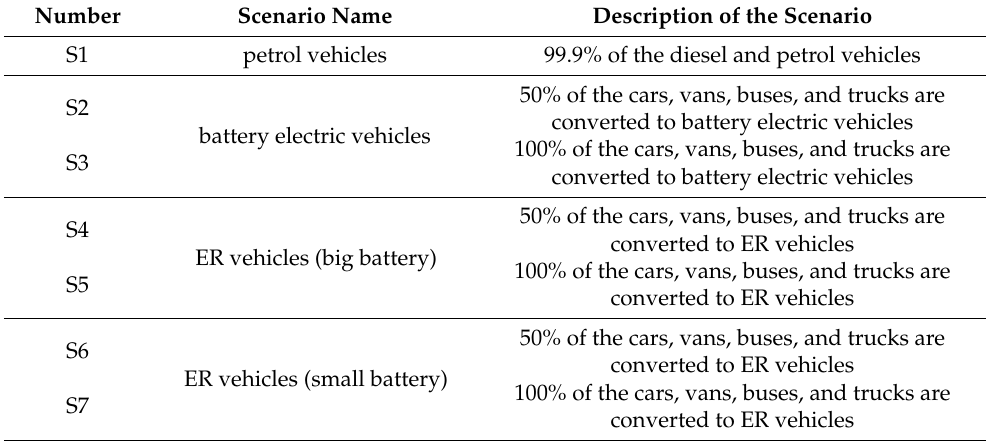
Table 4. Summary of the scenarios analyzed in this